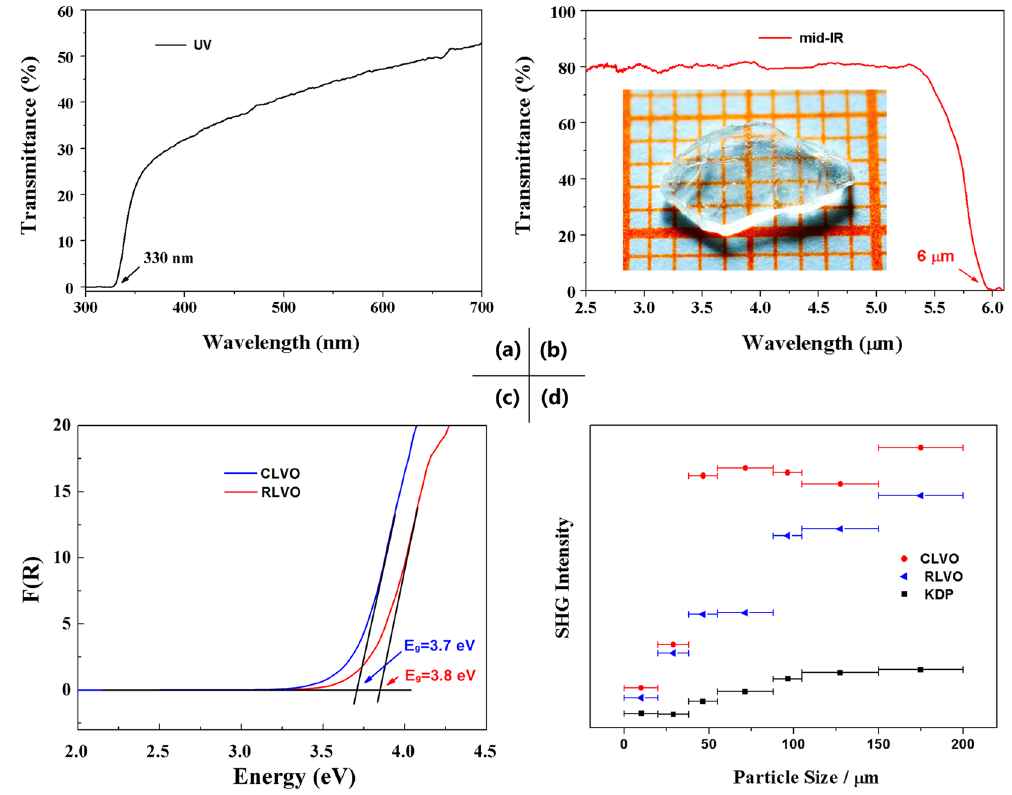
Figure 4. Linear and nonlinear optical properties of RLVO and CLVO. ( a ) The UV–vis–NIR and ( b ) Mid-IR transmittance spectrum on single crystal plate of CLVO, ( c ) UV-vis- NIR diffuse reflectance spectroscopy plots for RLVO and CLVO, ( d ) Phase-matching curves for RLVO and CLVO at 1064